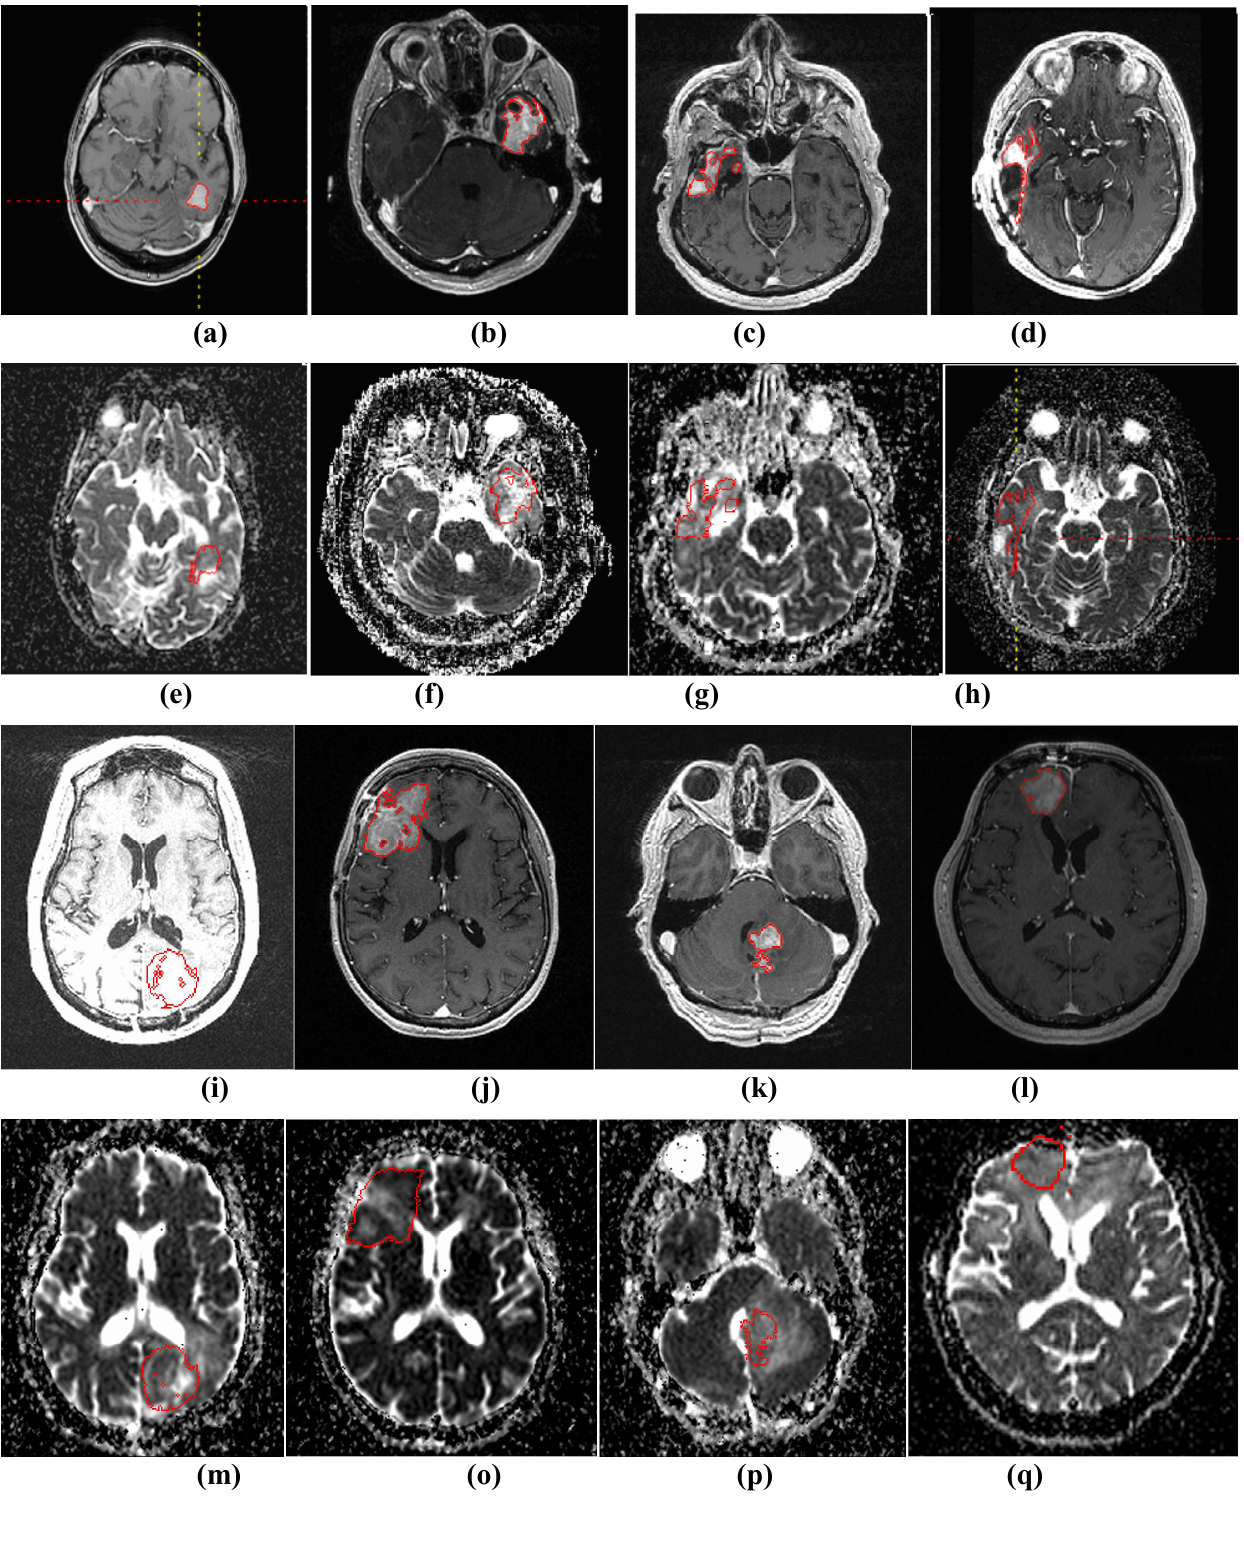
Figure 3. (a) - (d) and (i) - (l) show four examples of tumor segmentations on T1wCE images; (e) - (h) and (m) - (p) show the corresponding mapped tumor contours on ADC